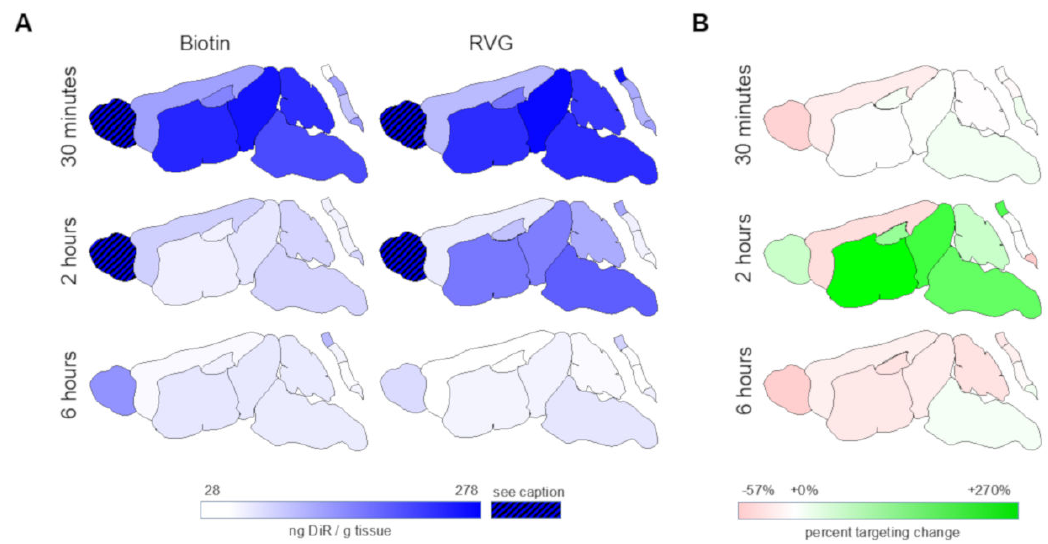
Figure 4. Delivery of payload from intranasally administered nanoparticles varies by central nervous system (CNS) region and surface modification. ( A ) Magnitude of DiR delivered from ctr-NPs (left) or RVG-NPs (right) nanoparticles. Data are scaled to min / max concentration for the entire data set excluding the olfactory bulb. Values for DiR delivery to the olfactory bulb that are out of range for visualization on this scale are listed in Table 2. ( B ) Percent targeting change calculated by dividing the concentration of DiR delivered from RVG-NPs nanoparticles by the concentration of DiR delivered from ctr-NPs nanoparticles for each tissue region. Data are scaled to the min / max concentration for the entire data set such that a value of 0 represents no di ff erence in delivery from a targeted nanoparticle compared to a control